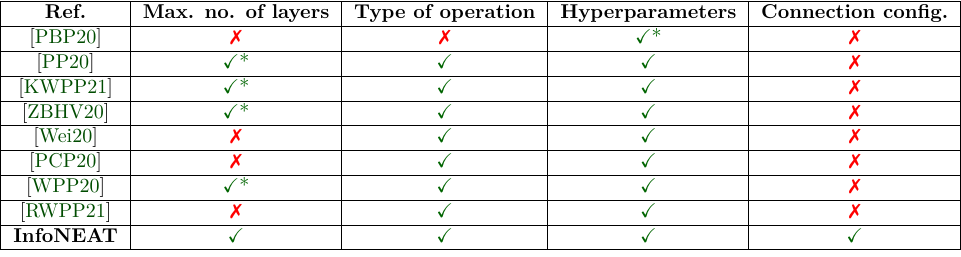
Table 9: InfoNEAT hyper/parameters, mainly set to the default values defined in NEAT. Parameters Description Values fitness Network parameters